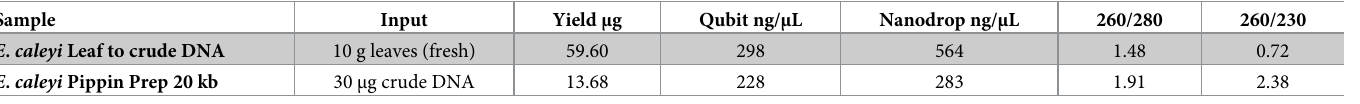
Table 1. Fluorometer and Spectrophotometer results of a DNA extraction for Eucalyptus caleyi . Firstly, crude DNA was extracted, which was then size selected for 20 kb and above with a PippinHT (Sage